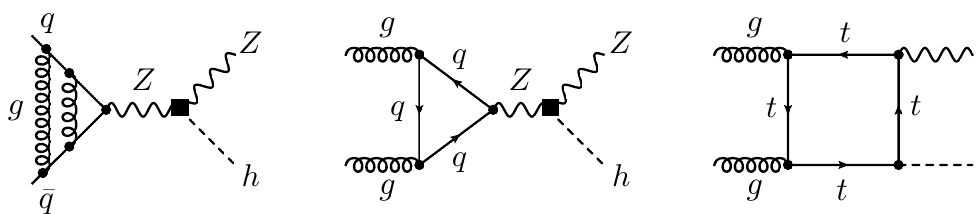
). As indicated by the black s